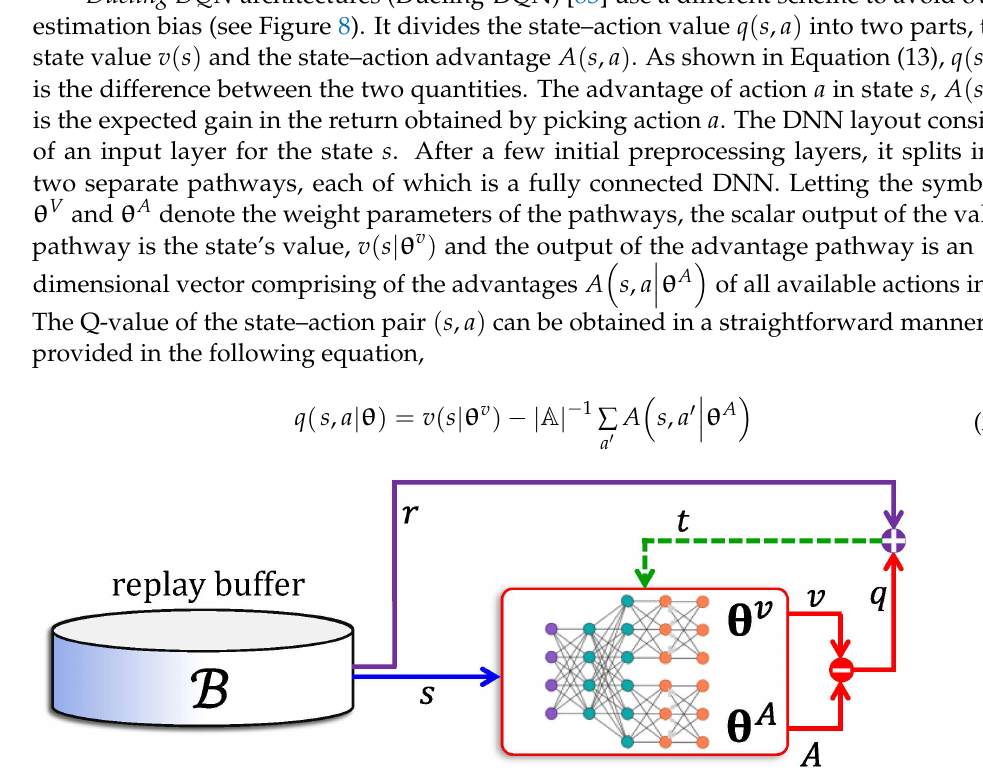
Figure 8. Dueling DQN. Shown is the dueling DQN architecture. The two outputs of the DNN are parametrized by θ v and θ A . The target pathway (dotted green) is for